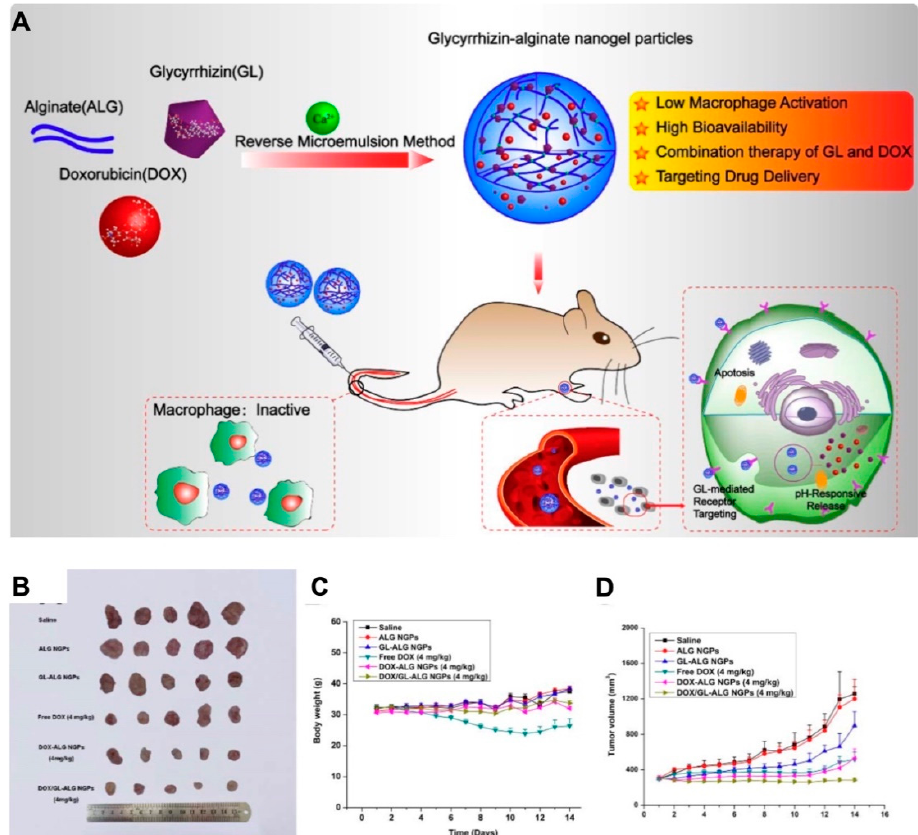
Figure 9. ( A ) The schematic illustration of alginate nanogel co-delivered with glycyrrhizin and doxorubicin (DOX/GL-ALG NGPs) for the improved anticancer therapy by inactivated macrophage and targeted drug delivery; the antitumor effect: photograph of tumors ( B ), body weight variation curve ( C ) and tumor growth curve ( D ) for each group after treatment. Reproduced from (Theranostics.